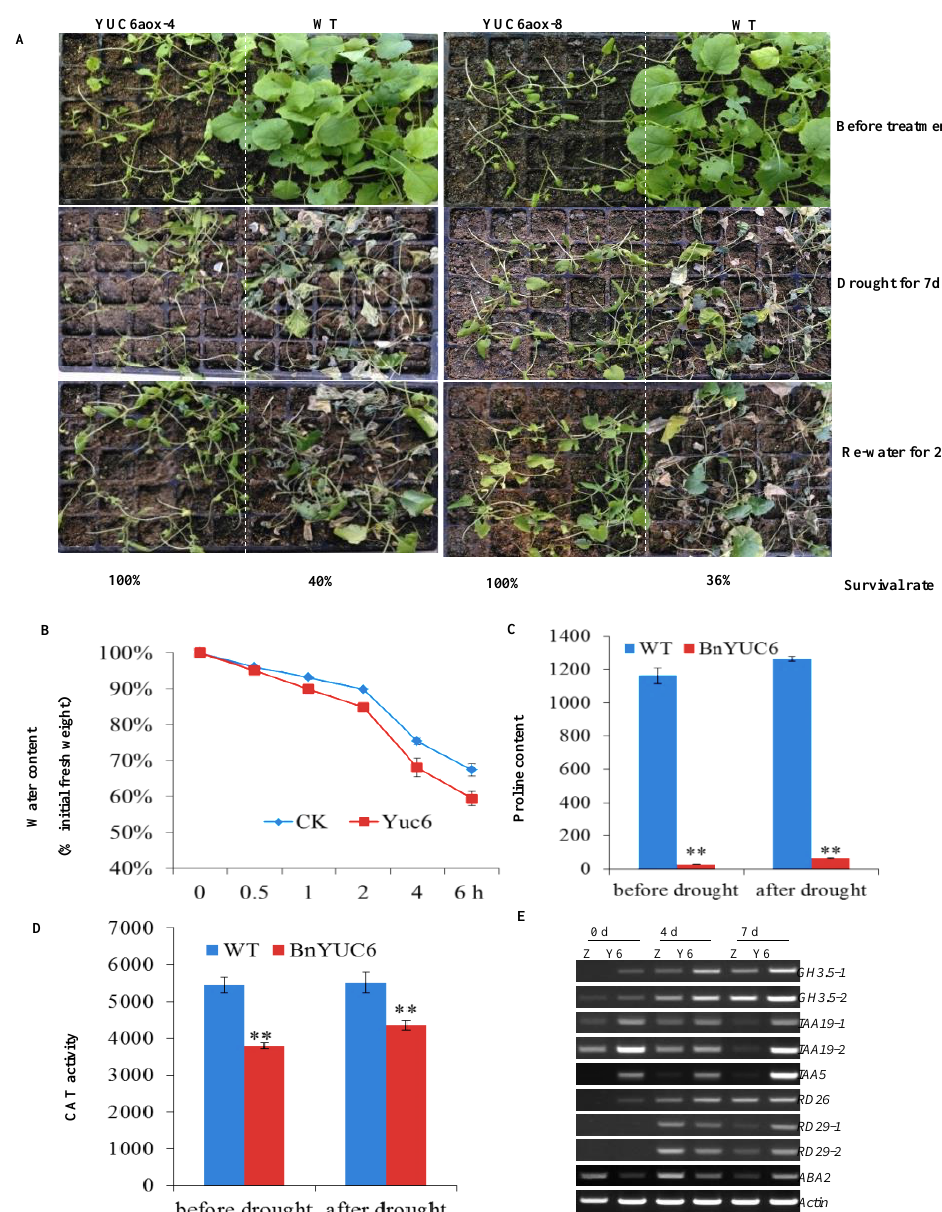
Figure 6. Overexpressed BnaYUC6a in B. napus increased drought resistance: ( A ) Two BnaYUC6a-ox lines and wild type seedlings were well grown for three weeks under normal conditions and were then photographed (first panel). After drought for seven days, the plants were photographed (two panel). The plants were then re-watered for two days and were photographed (third panel), and the survival rate (percent) in each sample was quantified, as shown at the bottom of the picture. ( B ) Water loss assays. Seedling plants were grown in soil for 4 weeks, and the third to fifth rosette leaves were used. ( C ) Proline content detection. Leaves from four-week-old plants before drought or after drought for 4 days were used to detect proline content. ( D ) CAT activity detection. The sample was selected as a proline test. ( E ) Auxin- and ABA-responsive gene expression in YUC6a-ox and wild-type plants. The sample was harvested before drought or after drought for 4 and 7 days. Actin gene was used as the control. All statistical tests were performed with Student’s test. Bars indicate standard error of the mean (** p <